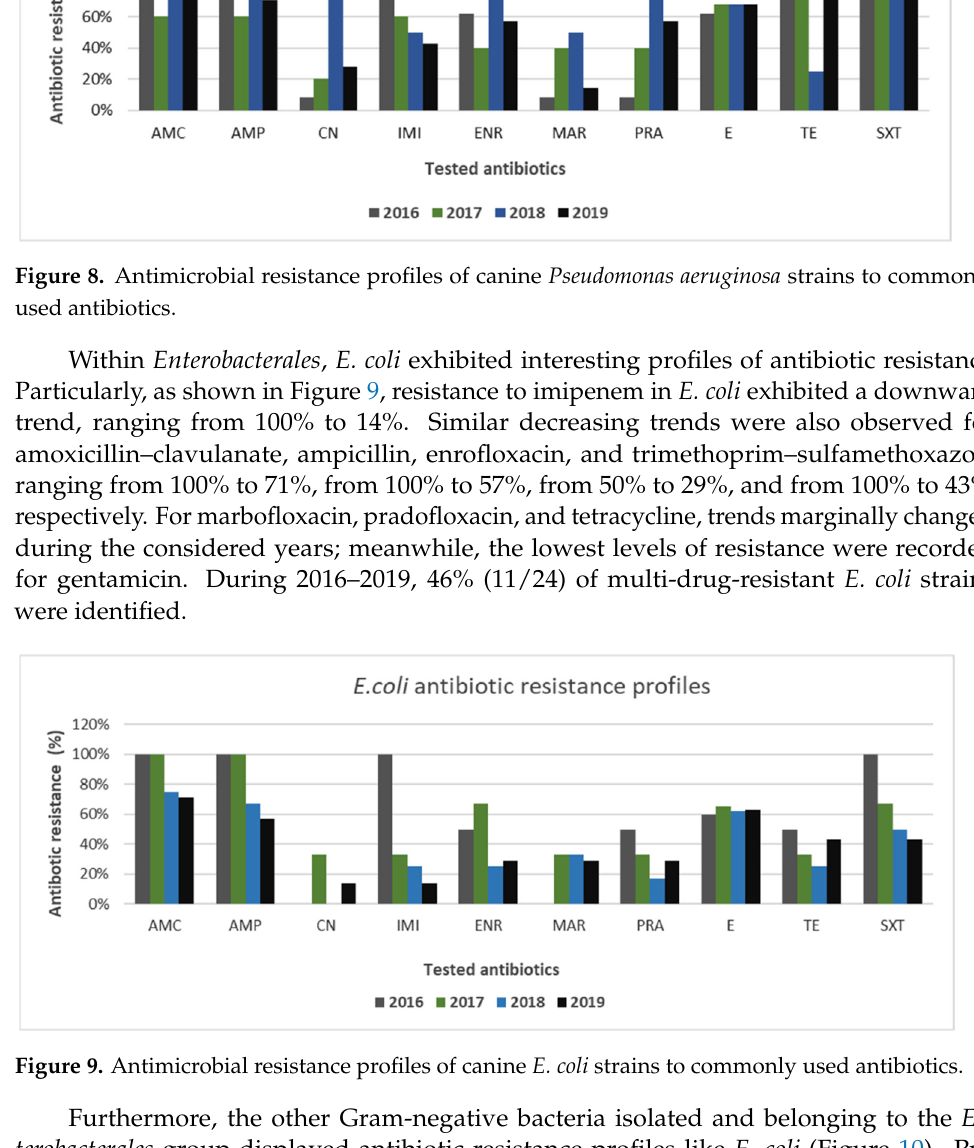
Figure 10. Antimicrobial resistance profiles of canine Enterobacterales strains to commonly used antibiotics. 4. Discussion In pet animals, skin infections represent the main reason for presentation to veteri- nary examination, often leading to empirical antimicrobial prescription in small animal practices [14,25,26]. Thus, timely detection, identification, and antimicrobial susceptibility testing of causative pathogens and their surveillance are needed to improve the manage- ment of otitis externa and pyoderma in pets and to prescribe a successful therapy. This study reports data on the prevalence of otitis externa and pyoderma in dogs and cats and the frequency of most isolated bacteria and evaluates their susceptibility profiles to the main antibiotics used in veterinary treatments in the period between January 2016 and December 2019. Moreover, this retrospective research can be a guideline for clinicians, especially those in our veterinary teaching hospital, in making rational decisions on the